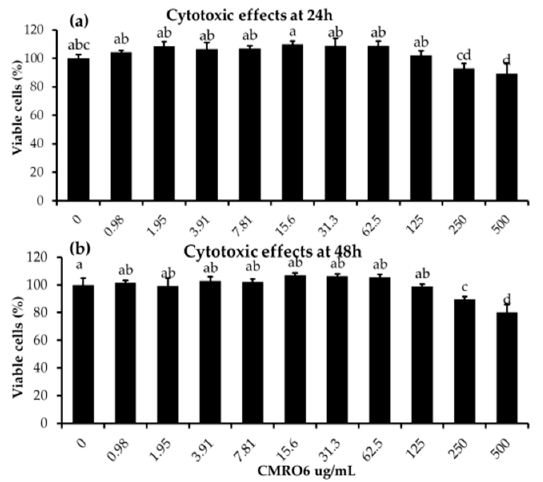
Figure 1. Cytotoxic effects of cell-free metabolites of B. ginsengihumi-RO6 (CMRO6) on 3T3-L1 pre- adipocytes. The cells were treated with different concentrations of CMRO6 (0.98–500µg/mL) and incubated under normal cell culture conditions. After that, cell viabilities were determined after 24 h and 48 h using EZ-cytox reagent. ( a ) The percentage of viable cells in the experimental groups at 24 h; ( b ) the percentage of viable cells in the experimental groups at 48 h. The data are presented as the mean ± STD for six replicates (n = 6). Different letters within the figure indicate significant differences between groups ( p < 0.05).